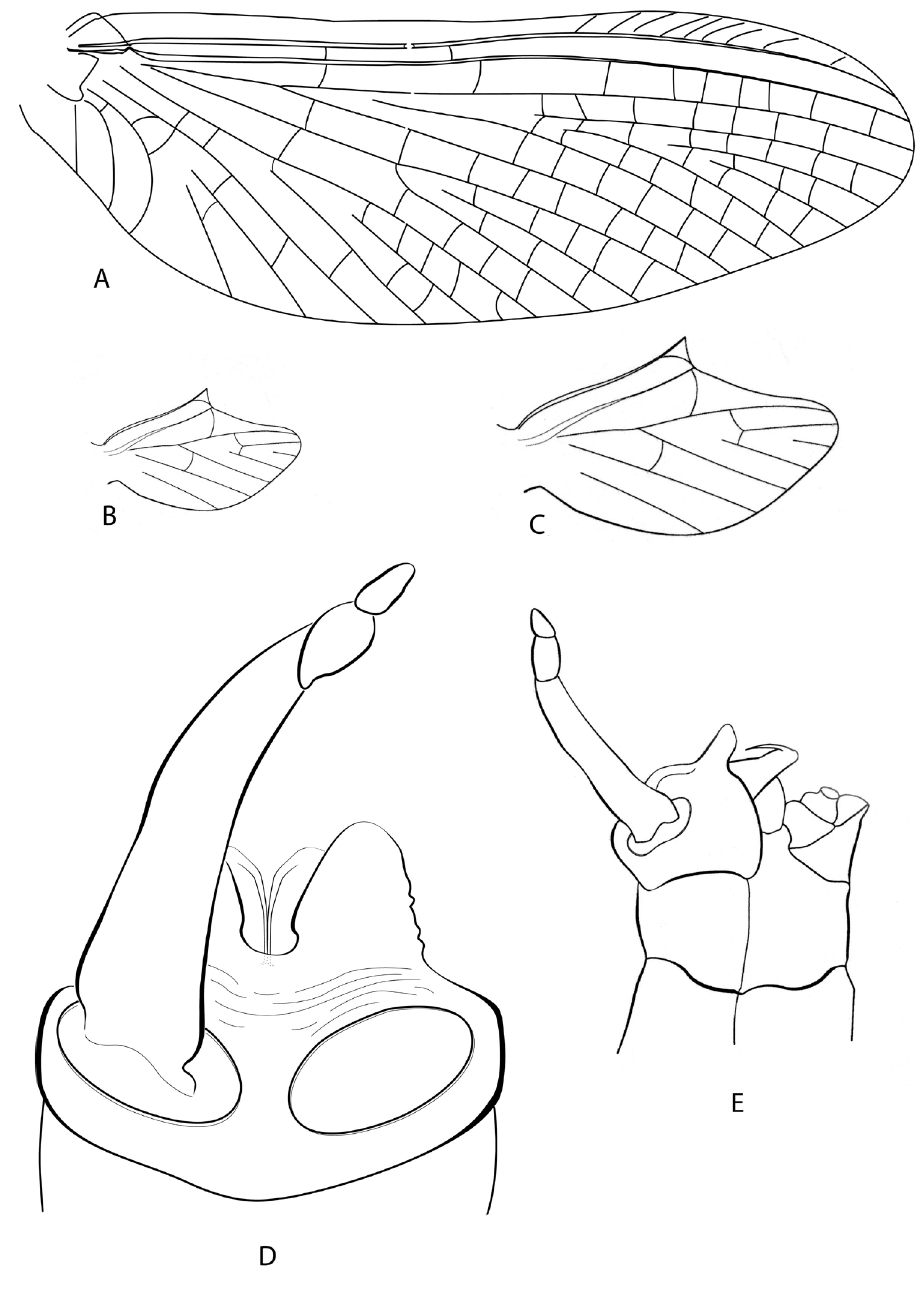
Figure 2. Hydrosmilodon gilliesae , male imago: a fore wing b hind wing c hind wing, enlarged d genitalia, ventral view e genitalia, lateral